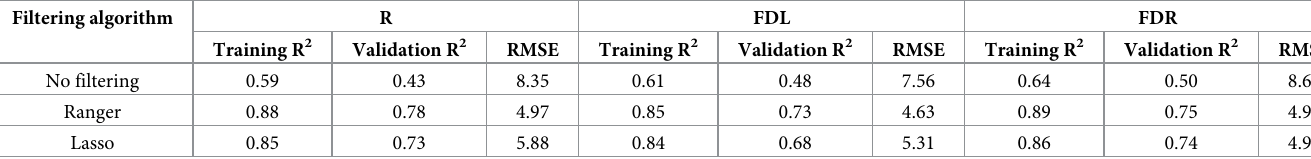
Table 3. Comparison of modeling results between two filter algorithms. Filtering